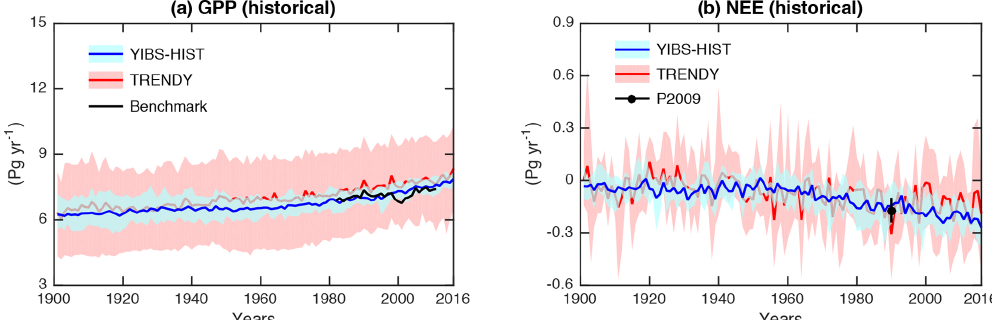
Figure 4. Historical carbon fluxes in China. Results shown are simulated (a) gross primary productivity (GPP) and (b) net ecosystem ex- change (NEE) during the historical period (1901–2016) using YIBs (blue), and the comparison with predictions of 14 terrestrial models from TRENDY project (red). The bold lines are ensemble means with red shadings for inter-vegetation-model uncertainties and blue shadings for inter-climate-model uncertainties. All YIBs simulations are driven with daily meteorology from CMIP5 models. All TRENDY simulations are driven with CRU-NCEP meteorology. The black line in (a) represents benchmark results of 1980–2011 from Jung et al. (2009). The black point with an error bar in (b) represents the synthesis of ground- and model-based estimates of NEE in China by Piao et al. (2009).